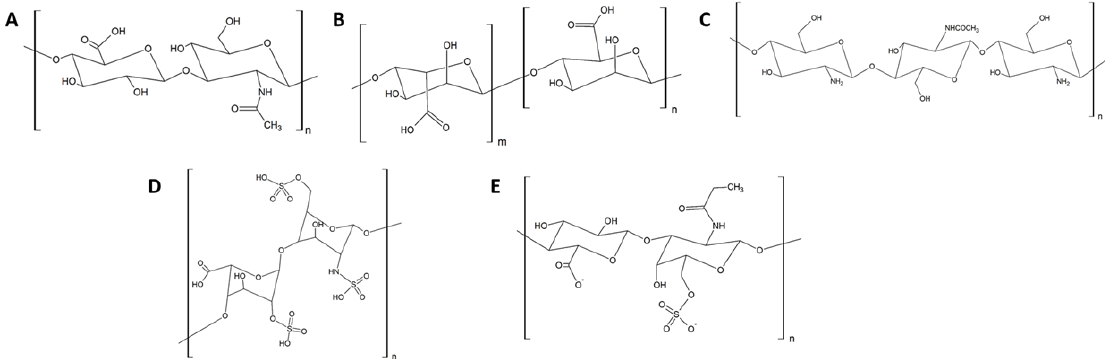
Figure 3. Main polysaccharides used in anti-adhesive coatings. ( A ) Hyaluronic acid, ( B ) alginate, ( C ) chitosan, ( D ) heparin, and ( E ) chondroitin.